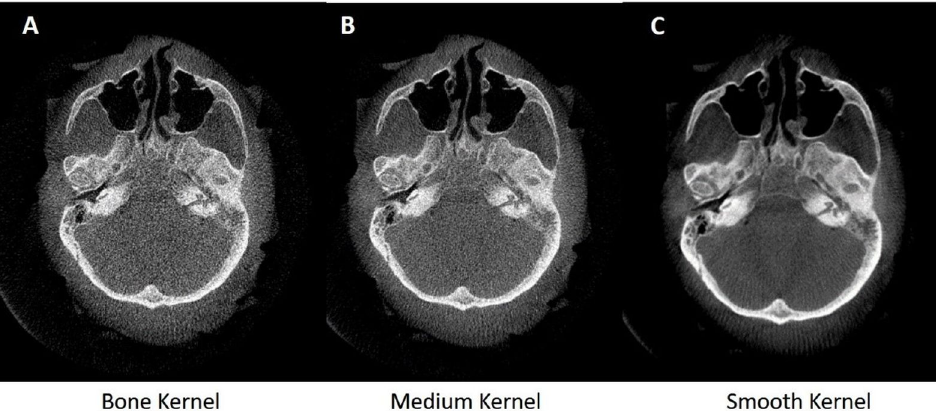
Figure 3. Post-processed data set of a scan with 121 kV / DL 278 and pre-filtration with 0.2 mm copper, raw datasets. Higher image noise in ( A ) than in ( B ) and ( C ). Blurred visualisation of bony edges in ( C ) compared to ( A ) and ( B ). ( B ) was rated as the best compromise.